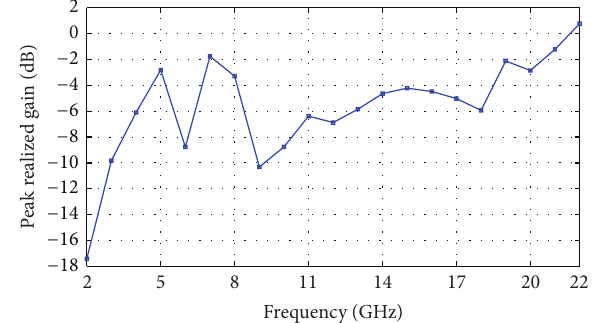
Figure12:Simulatedpeakrealizedgainversusfrequencyofthefilter in a back-to-back